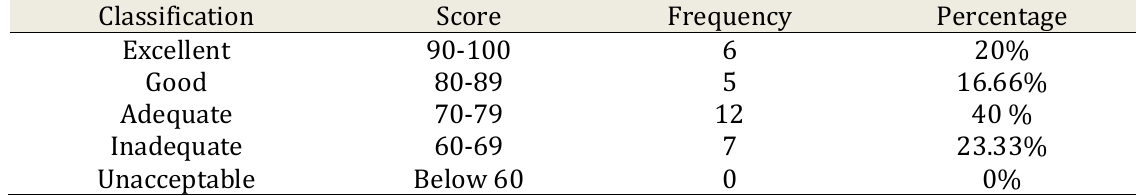
Table 2. the students’ post -test result in experimental class